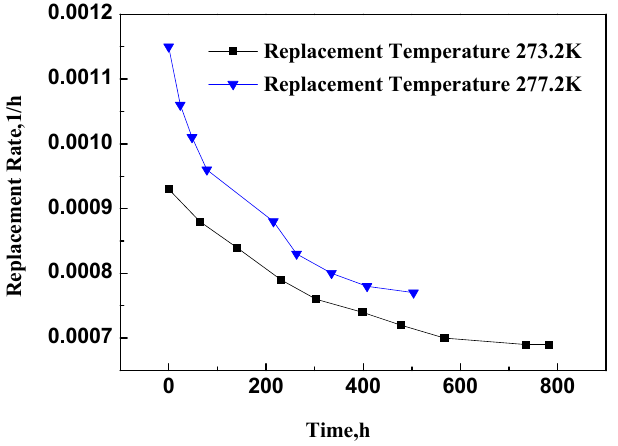
4. Variation of the replacement rate with elapsed time at different replacement temperatures.